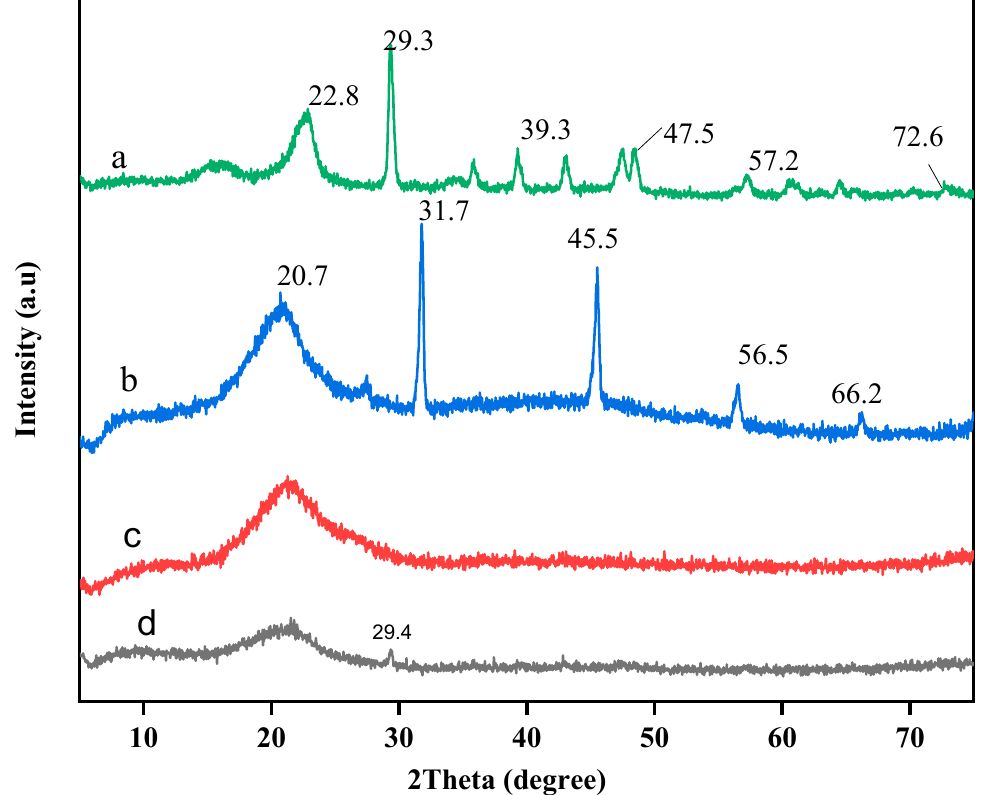
Figure 3. XRD patterns of blended paper ( a ), HPMC ( b ), SRF1 ( c ), SRF2 ( d ) .